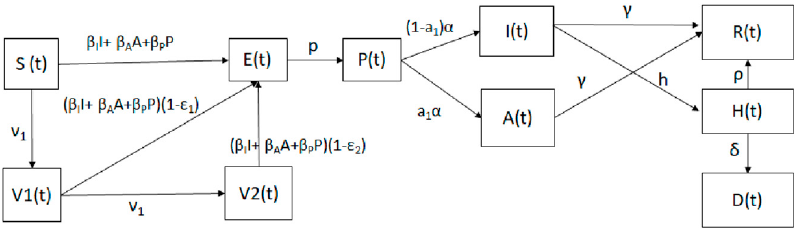
Figure 1. Diagram for the COVID-19 mathematical model (1). The boxes represent the different classes and the arrows the transitions between these classes.